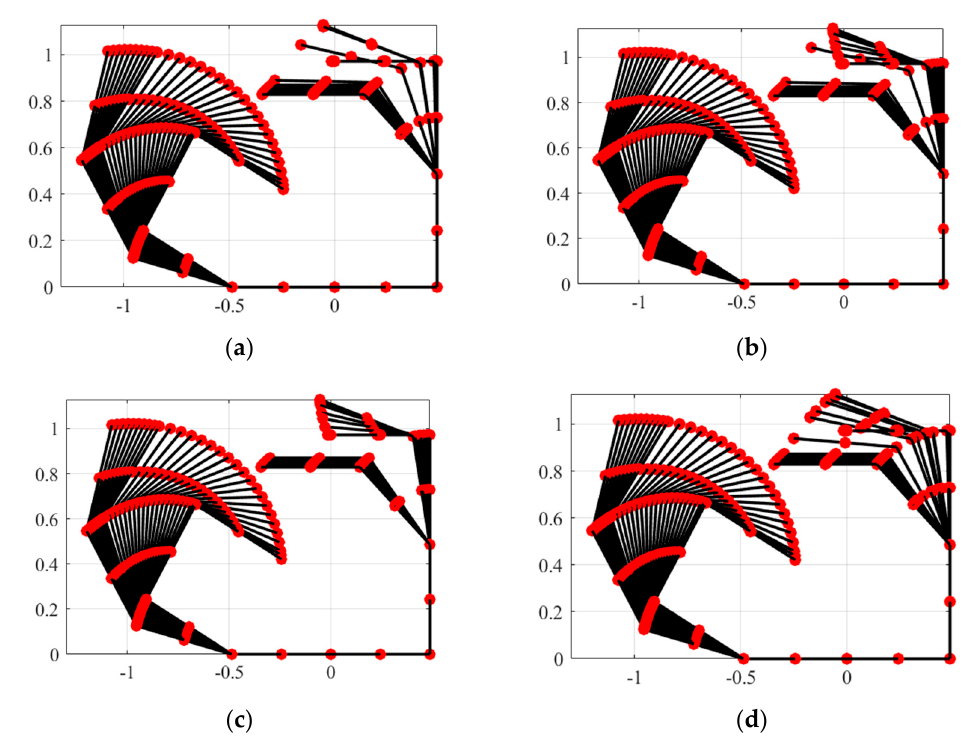
Figure 25. Reconfiguration processes of SMSRS under four collision-free paths : ( a ) path 1, ( b ) path